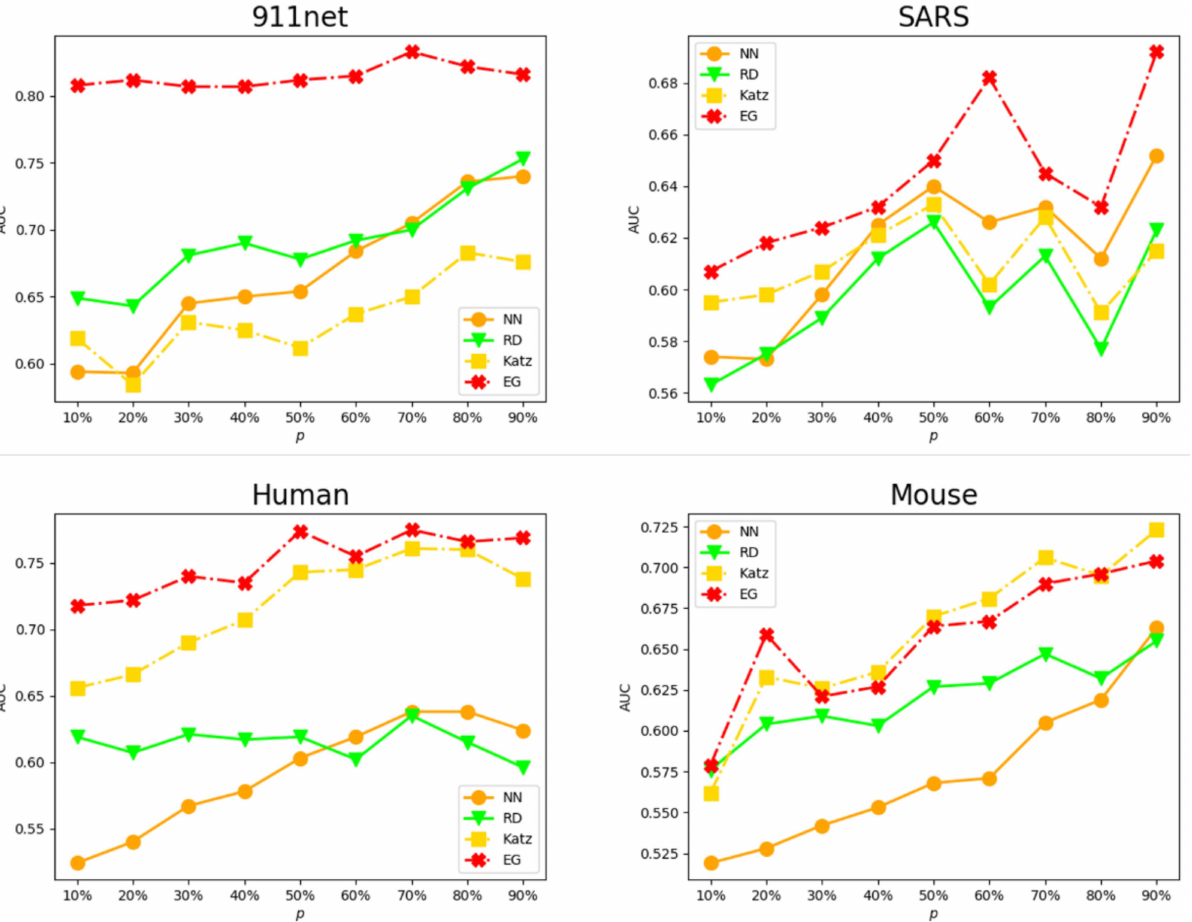
Figure 2. Comparison results from AUC s of the edge importance greedy strategy